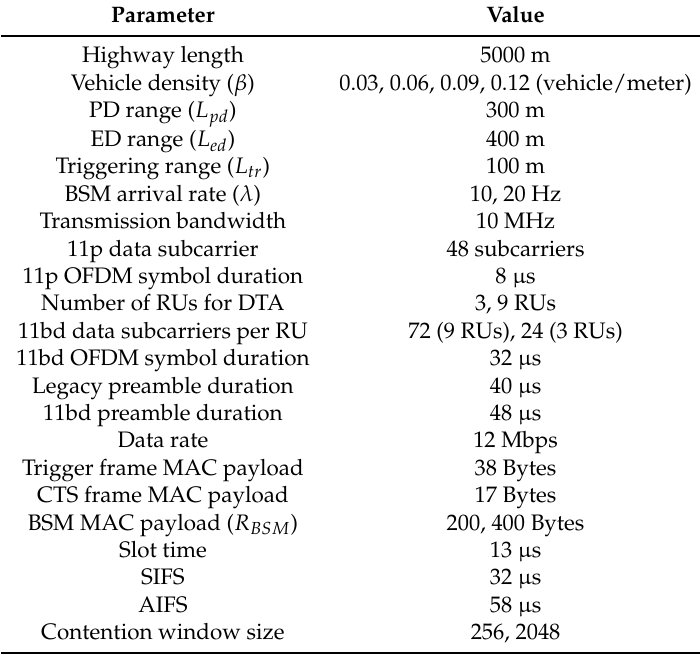
Table 1. Simulation parameters.